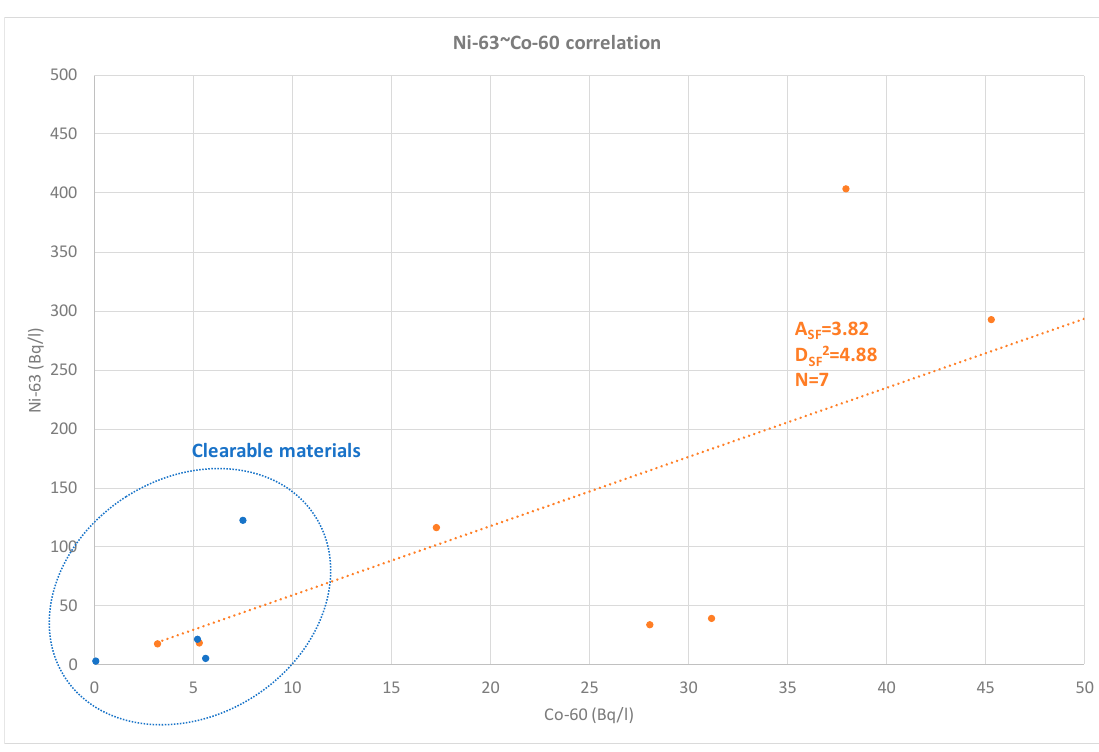
Figure 6. Ni-63~Co-60 correlation present in the Trino “E. Fermi” clearable materials.